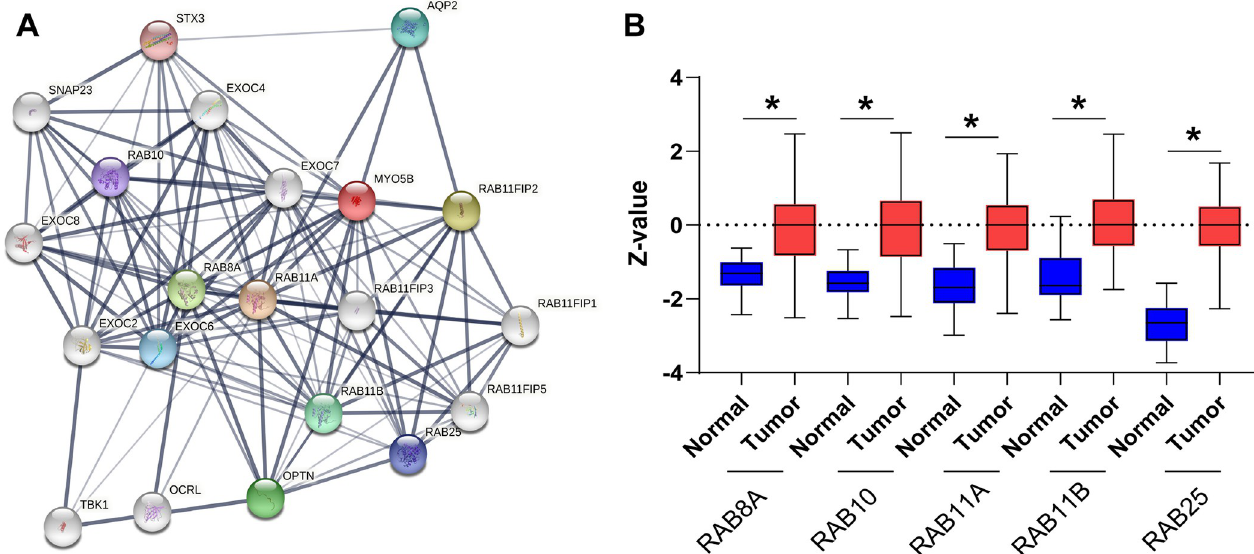
Fig 6. Protein networks indicate MYO5B closely interacts with RAB binding partners. A. Protein-protein interaction networks based on MYO5B (red circle). Active interactions are depicted by the thickness of the lines, with thicker lines indicating stronger confidence of the interaction. B. Protein levels of normal and grouped UCEC tumor samples for RAB8A, RAB10, RAB11A, RAB11B, and RAB25. � p < 0.05.